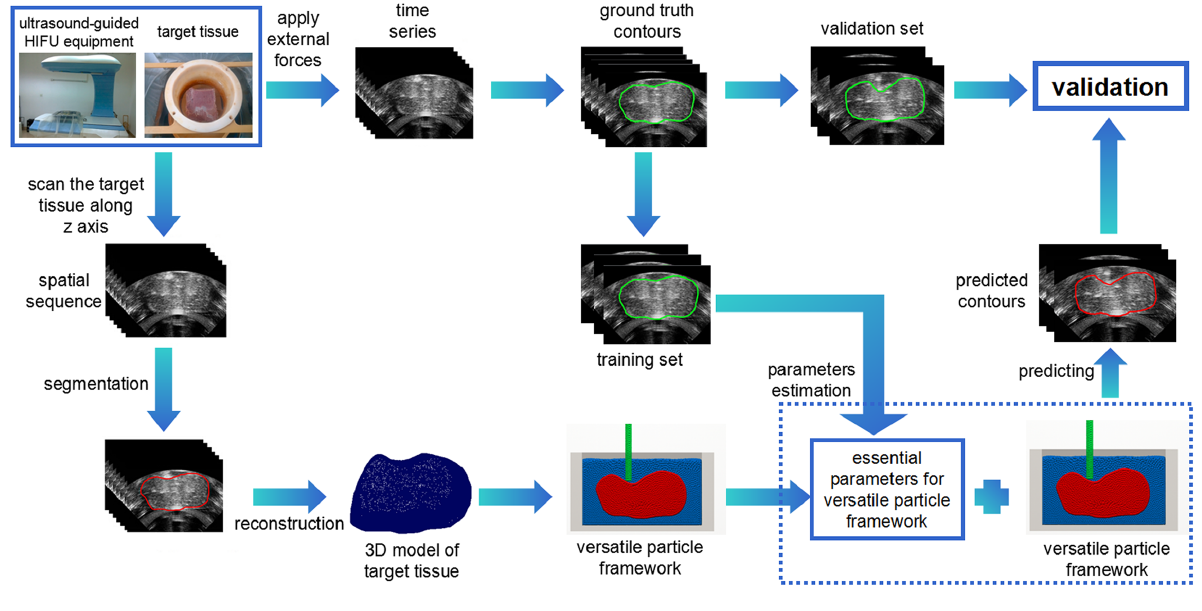
Fig 1. Process of dynamic modeling and prediction of target tissue movement and deformation: The target tissue is placed in the water pool of the ultrasound-guided HIFU equipment. First, we scan ultrasound images of spatial sequence of the target tissue and use the GLCV model to obtain the segmentation results, and then reconstruct a 3D model of the target tissue. Second, we apply the external force to the target tissue using a rigid body while the ultrasound-guided HIFU equipment records time series of ultrasound images of the target tissue ’ s one cross section. The segmentation results are manually segmented by an experienced doctor and as the ground truth which is divided into two parts: training set and validation set. Third, we propose a versatile particle framework to model the movement and deformation of target tissue. Combined with the versatile particle framework, the external force and other essential parameters are acquired through the iterative parameter estimation algorithm. By applying these parameters to the versatile particle framework, we predict the target tissue ’ s subsequent movement and deformation, which is used to compare with the validation set to verify the effectiveness of our